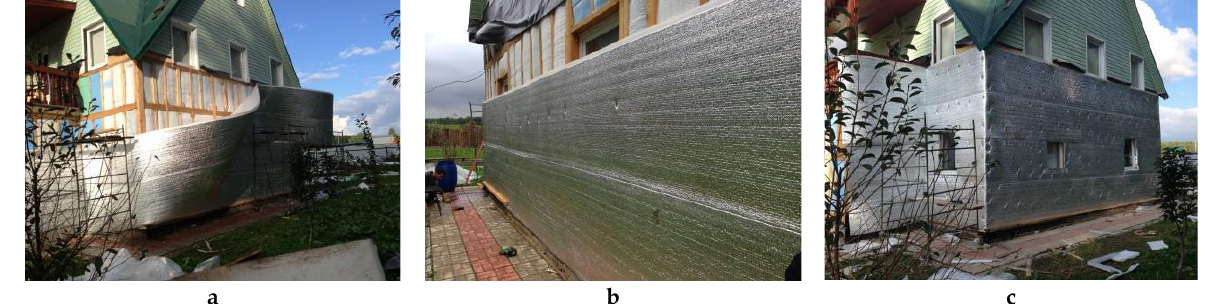
Figure 10. Thermal insulation of the cottage: ( a ) unrolling the roll of polyethylene foam; ( b ) fixing the insulation on the outer contour of the building and stitching the roll of polyethylene foam; ( c ) the insulating shell and window openings.